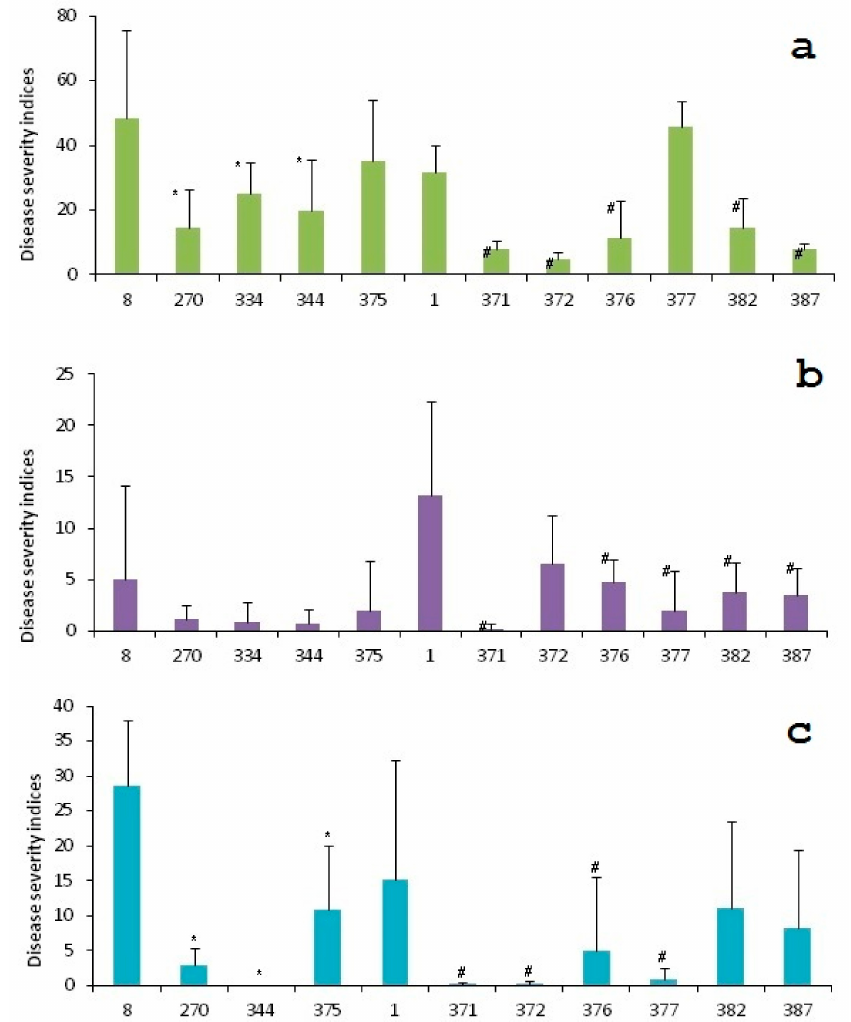
Figure 5. Disease severity indices ( DSI ) of the transformants inoculated with Alternaria spp. The inoculations were performed in 2012 ( a ), 2014 ( b ) and in 2015 with the Udacha transformants and in 2016 with the Zhukovsky ranny transformants ( c ). * and # designate lines significantly different from the initial variety ( p <